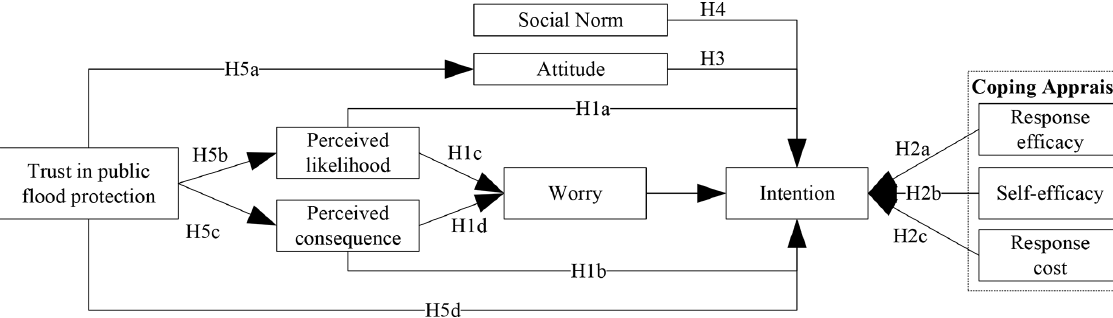
Figure 1. Framework of the integration